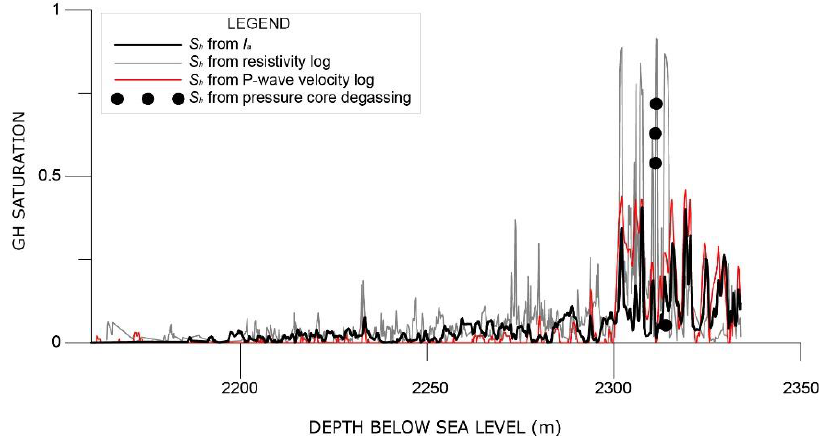
Figure 9. GH saturation estimated with various methods at the UBGH2-6 well. The black line shows the GH saturation estimated using Equation (5) in this study. Grey line indicates the GH saturation estimated from the resistivity log. Red line refers to the GH saturation estimated from the P-wave velocity. Black dots show the GH saturation estimated from pressure core degassing.